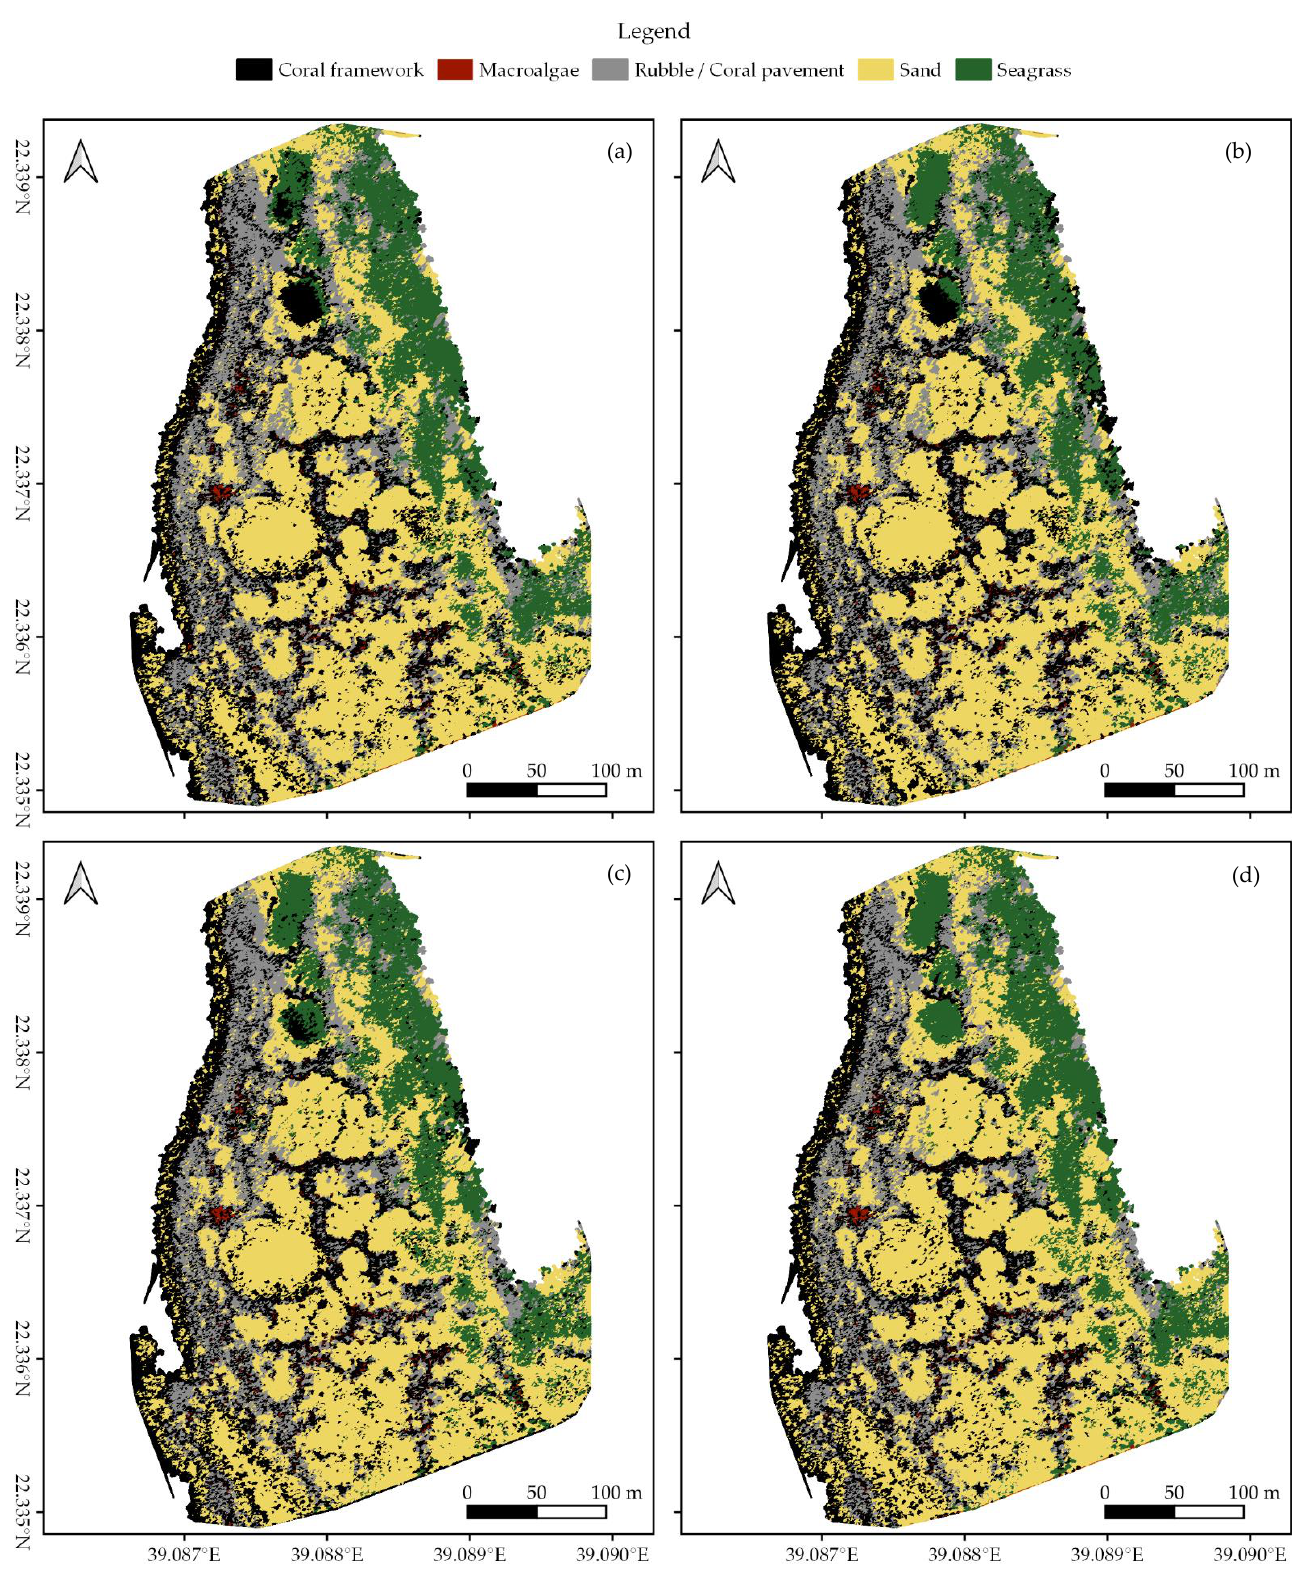
Figure 4. Habitat classifications of Area 2 (Figure 1) for classification protocol ( a ) 1. ‘Traditional classification’; ( b ) 2. ‘Using reef zones’; ( c ) 3. ‘Using geomorphometric features’; ( d ) 4. ‘Reef zones and geomorphometric features’ (Table 2).